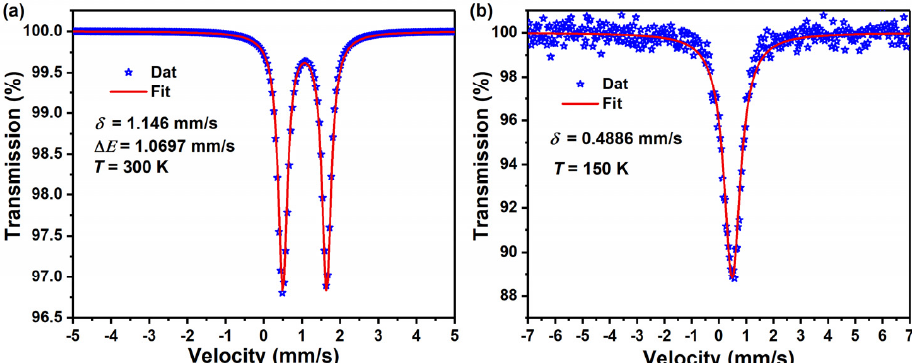
Figure 3. 57 Fe Mössbauer spectra for 1 measured at T = 300 K ( a ) and 150 K ( b ). Experimental data: empty stars. Calculated data: red full